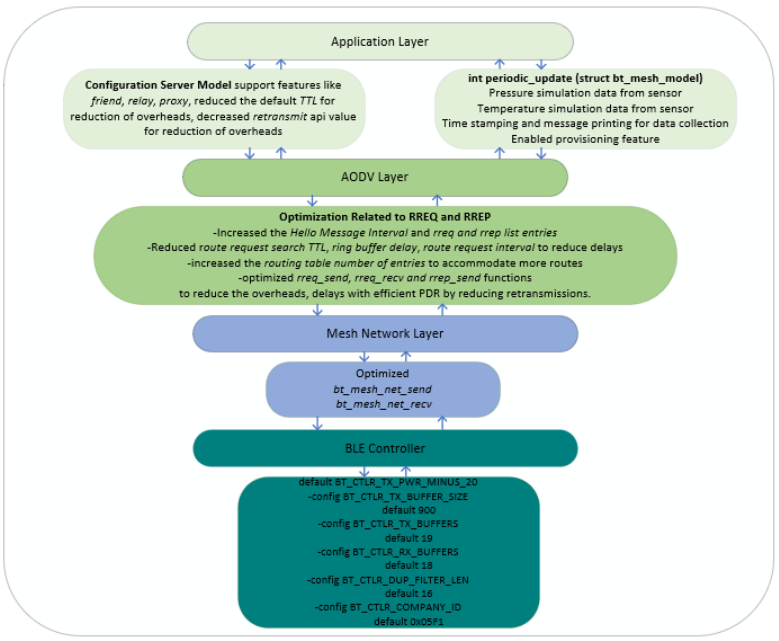
Figure 7. Flowchart depicting the protocol